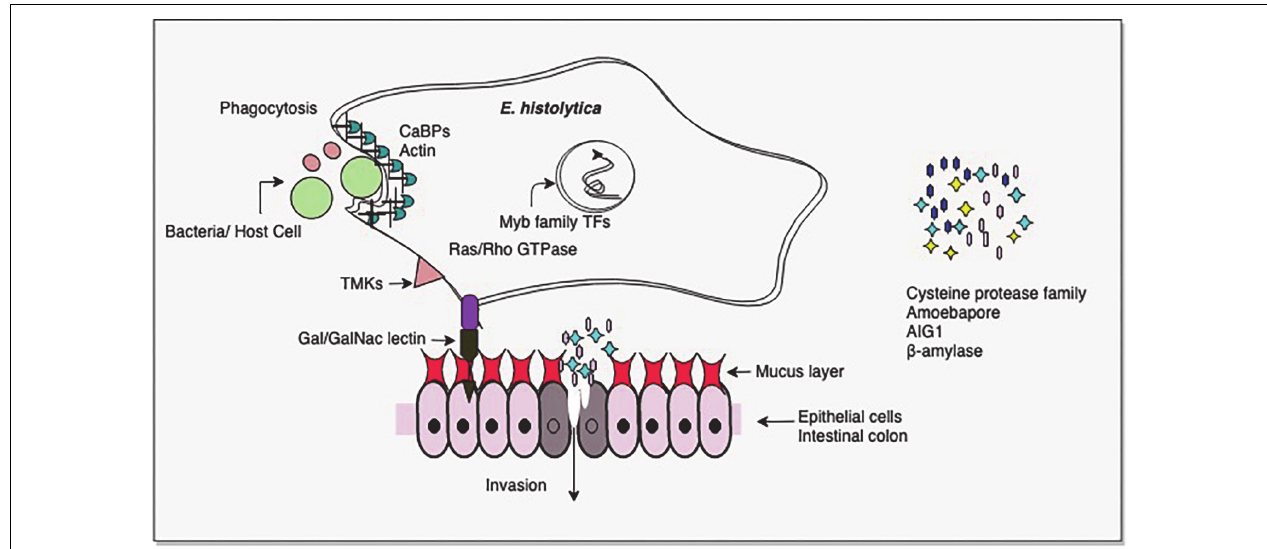
FIGURE 2 | Important virulence-related molecules revealed from transcriptomic studies. Cysteine proteases and β -amylase assist in tissue invasion. β -amylase helps in mucus depletion and utilization. AIG1 functions in defense against intestinal bacteria and amoebapores mediate cell lysis. Contact of host cell ligands is facilitated by Gal/GalNAc-inhibitable lectin. Trans membrane kinases (TMKs) and Ras/Rho GTPases are involved in signal transduction. Myb family transcription factors regulate the expression of multiple pathways. Phagocytosis of bacteria/host cells requires the activity of a large number of proteins, including calcium binding proteins (CaBPs) which mediate actin reorganization. Please see text for